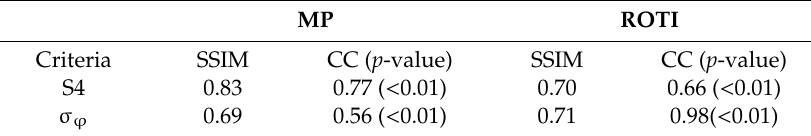
Table 5. SSIM and CC between the maps shown in Figure 7b.